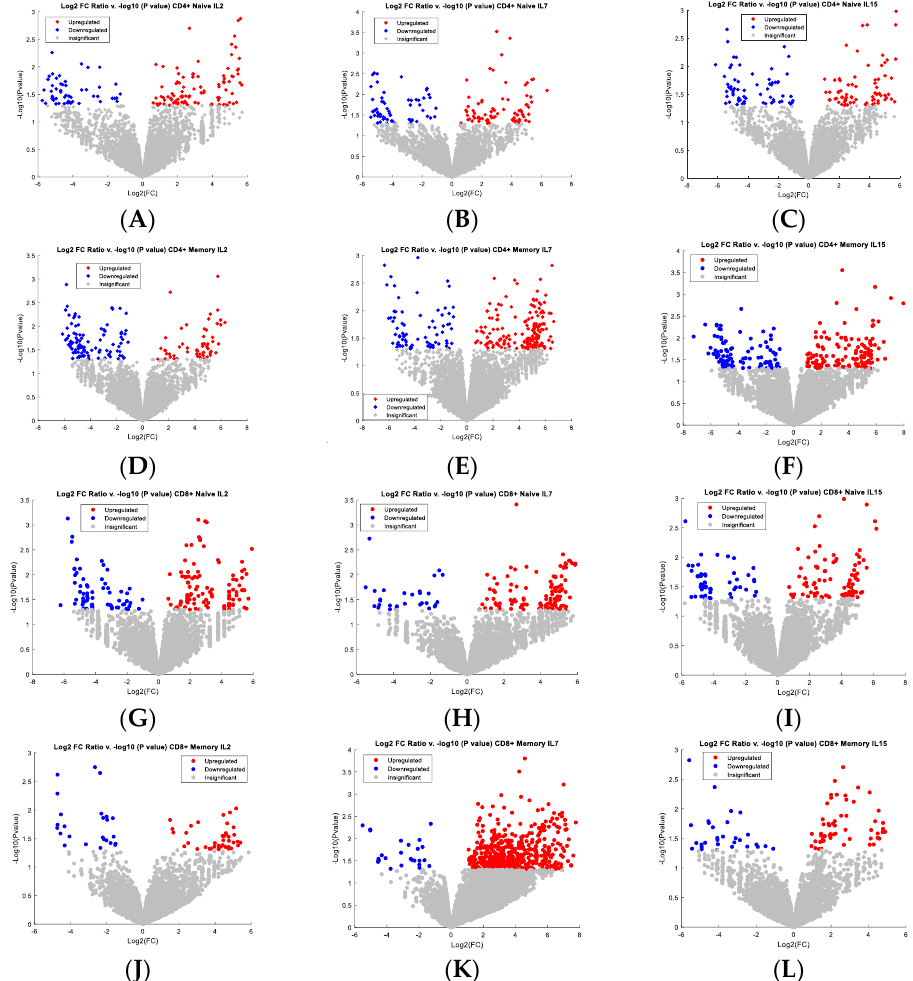
Figure 2. ( A ) CD 4+ naïve T cells response to highest IL- 2 concentration (condition “200”); ( B ) CD 4+ naive T cells response to highest IL- 7 concentration (i.e., condition “020”); ( C ) CD 4+ naive T cells response to highest IL- 15 concentration (i.e., condition “002)”; ( D ) CD 4+ memory T cell response to highest IL-2 concentration; ( E ) CD 4+ memory T cell response to highest IL-7 concentration; ( F ) CD 4+ memory T cell response to highest IL-15 concentration; ( G ) CD 8+ naïve T cell response to highest IL- 2 concentration; ( H ) CD 8+ naïve T cell response to highest IL-7 concentration; ( I ) CD 8+ naïve T cell response to highest IL-15 concentration; ( J ) CD 8+ memory T cell response to highest IL-2 concentration, ( K ) CD 8+ memory T cell response to highest IL-7 concentration; ( L ) CD 8+ memory T cell response to highest IL-15 concentration.